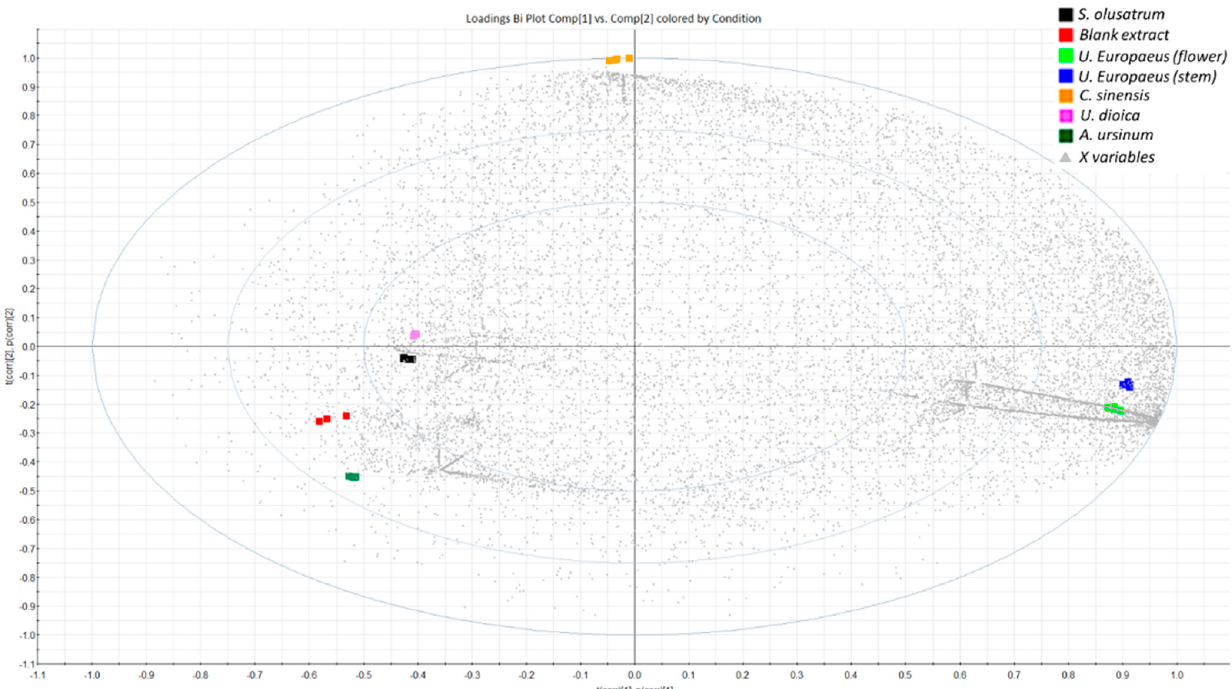
Figure 2. Loadings bi-plot showing tight clustering of sample types within the data swarm.